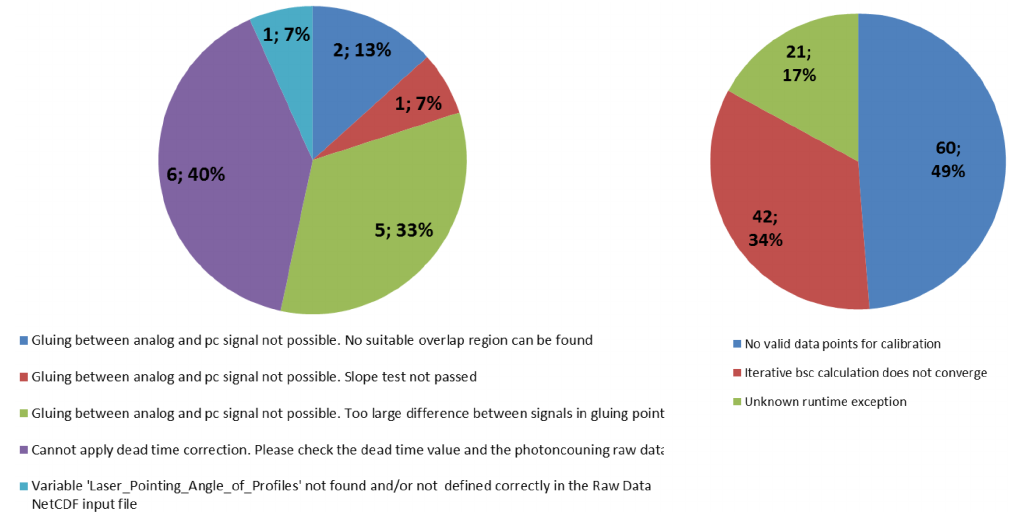
Figure 2. Number and frequency (in %) of the reasons for which either the pre-processing (ELPP, left) or the optical processing (ELDA, right) could not derive a solution. The color legend indicates the error